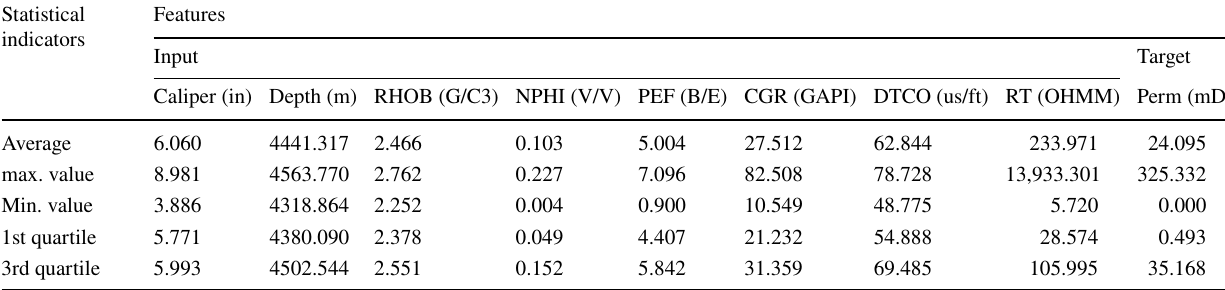
Table 2 Statistics on the collected data over the studied depth interval at the studied well (Matinkia et al. 2022b) Statistical